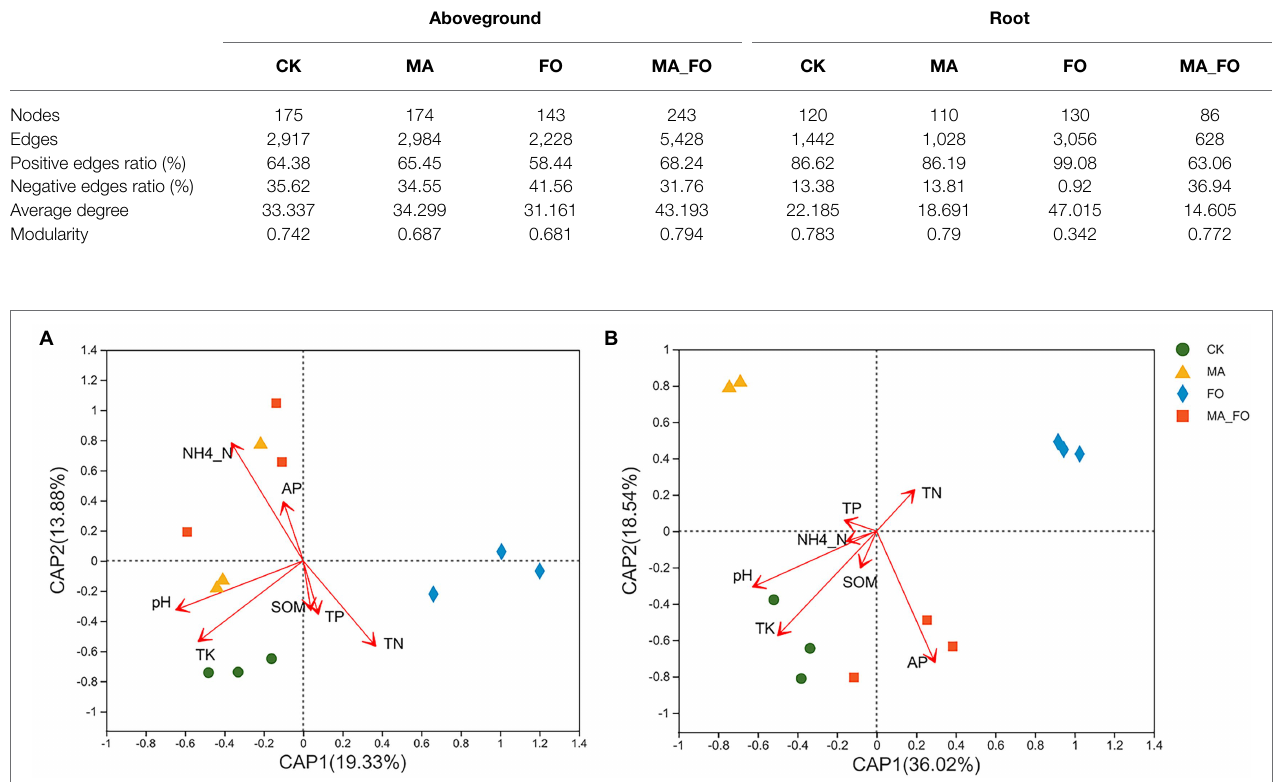
( Figure 7B ). Fusarium and Mortierella could colonize soil and become the dominant genera in FO and MA, with relative abundances of 41.3% and 57%, respectively. The relative abundance of Fusarium in MA_FO was significantly lower than that in FO, but the abundance of Pseudeurotium and Schizothecium was significantly higher ( Figure 8 ).